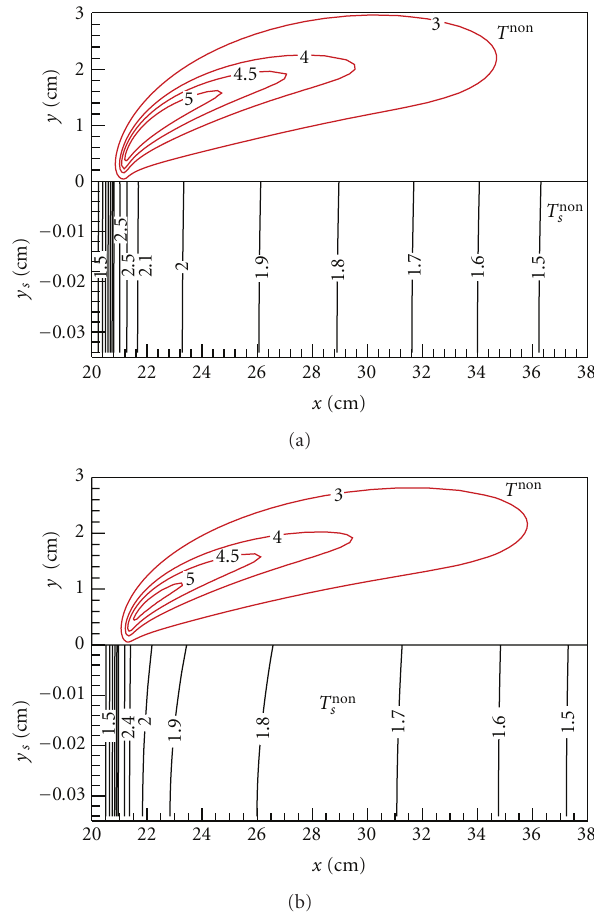
Figure 4: Temperature profiles of the gaseous flame and the solid phase at the steady state (a) with the zeroth-order pyrolysis model and (b) with the first-order pyrolysis model. Upper plane: nondimensional gas-phase temperature contours. Lower plane: nondimensional solid-phase temperature contours. Temperature is nondimensionalized by 300K. Ordinate scales are di ff erent in y (gas-phase) and y s (solid